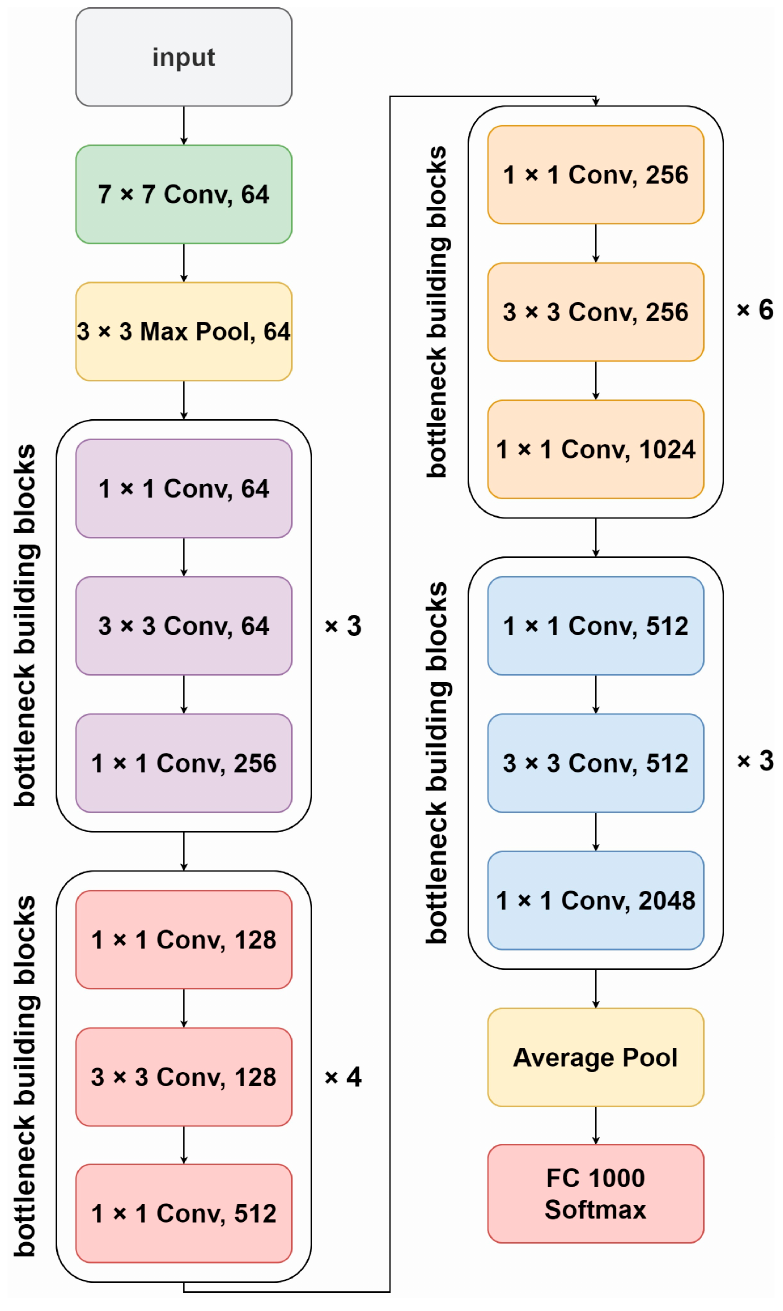
Figure 7. ResNet-50